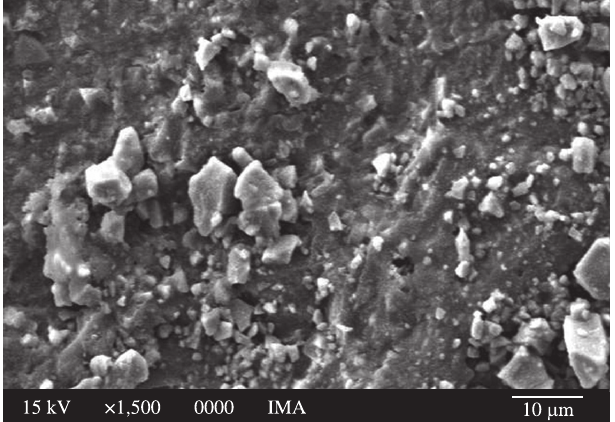
Figure 4. SEM photomicrograph of the polymerized